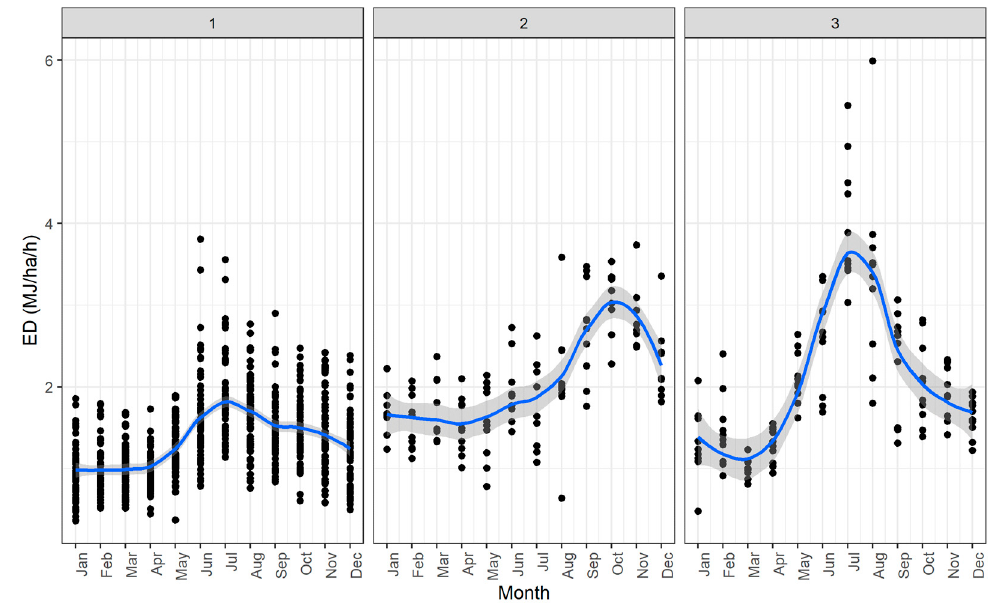
Water 2019 , 11 , x FOR PEER REVIEW Figure 7. Stations’ clusters using monthly distribution of ED values. Figure 7. Stations’ clusters using monthly distribution of 𝐸𝐷 values.